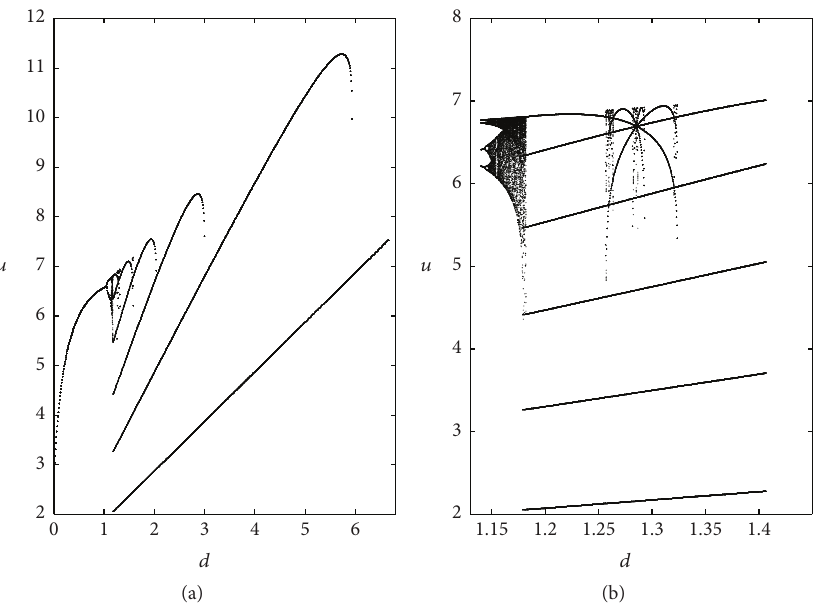
Figure 5: (a) Bifurcation diagram of the adaptation variable of system (2) with 𝐼 hom = 0.1485 , 𝑎 = 0.5 , 𝑏 = 1 , 𝑐 = 2.5 , V 𝑝 = 3 , and 𝑑 ∈ [0,6.66] . (b) The magnified part of